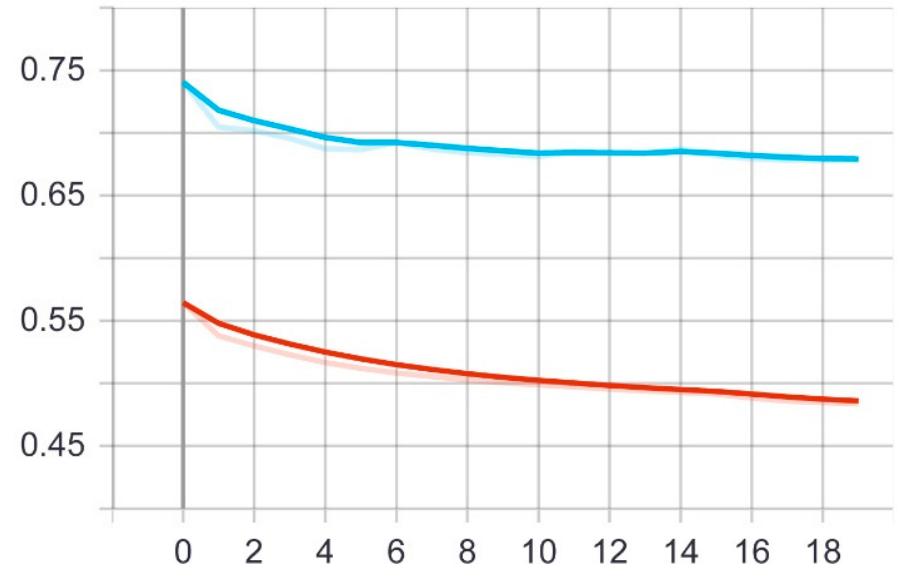
Figure 6. Accuracy (red line) and validation (blue line) loss curves of the first model over 20 epochs.